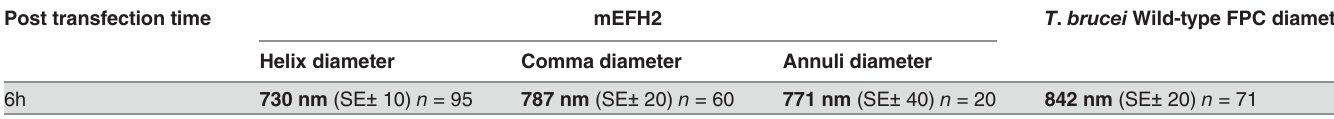
The mEFH2 helix diameter, comma diameter and annuli diameter were measured after six hours post-transfection. Helix, comma, annuli and FPC diameters all have similar diameters. FPC diameter was measured on wild-type T . brucei procyclic cells.